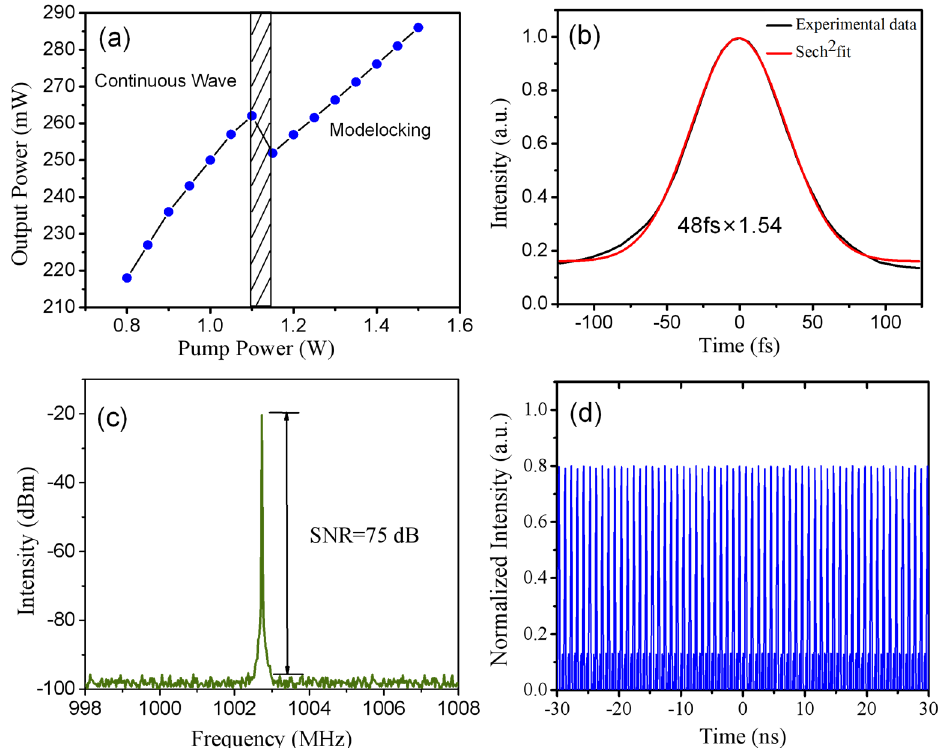
Figure 2. ( a ) Experimentally measured average output powers with increased pump powers. ( b ) The autocorrelation traces of experimentally measured (black solid curve) and hyperbolic secant fitting (red solid curve) pulses. ( c ) Radio frequency (RF) spectrum, resolution bandwidth = 10 kHz. ( d ) The delivered pulse trains. The grating separation was set to 1.0 mm.